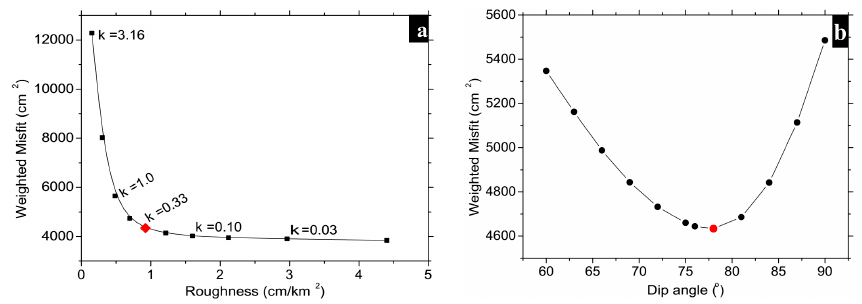
Figure 5. ( a ) Trade-off curve between the weighted misfit of data and slip roughness for the optimal dip angle (78°). The preferred smoothing factor used in our inversion is indicated by a red diamond. ( b ) The weighted misfit for testing different dip angles of the Muji fault. The optimal dip angle is denoted by a solid red circle and has a value of 78°.